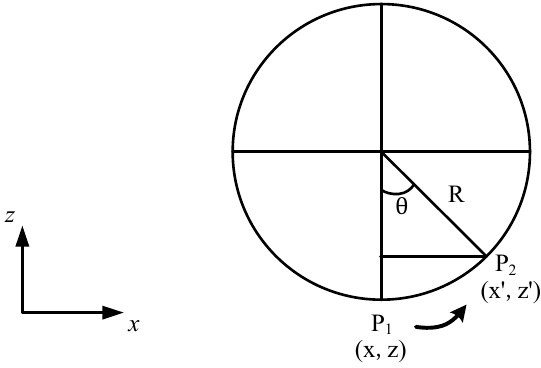
Figure 13. Trajectory of heat source centre.